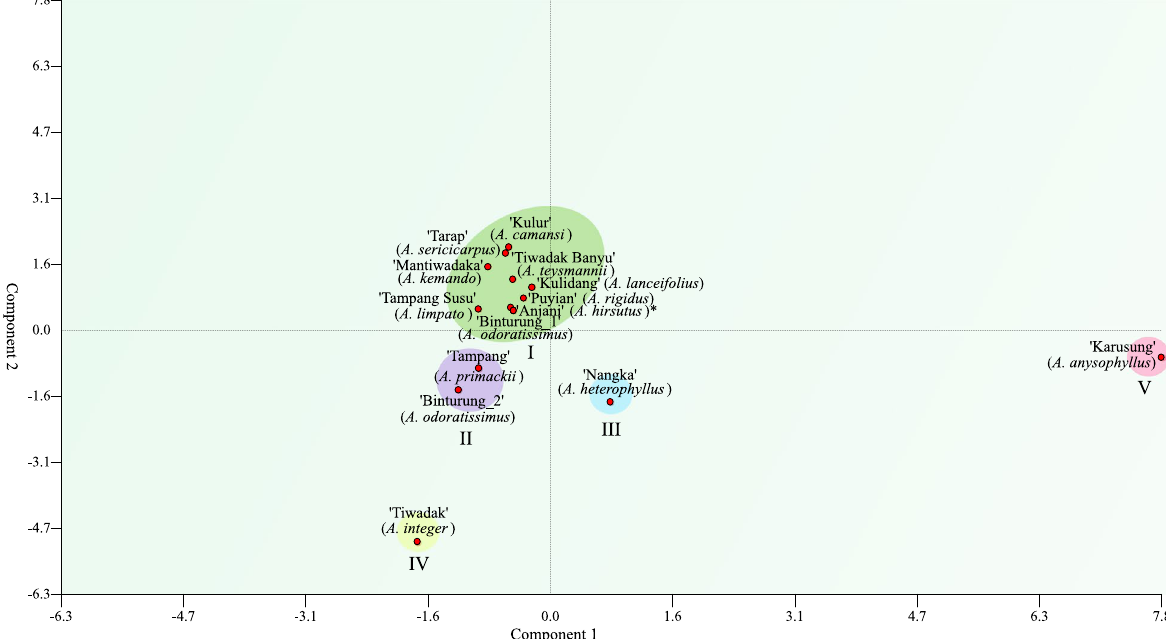
Fig. 7 Grouping of endemic breadfruit ( Artocarpus spp.) from South Borneo, Indonesia, into five main groups based on principal component analysis